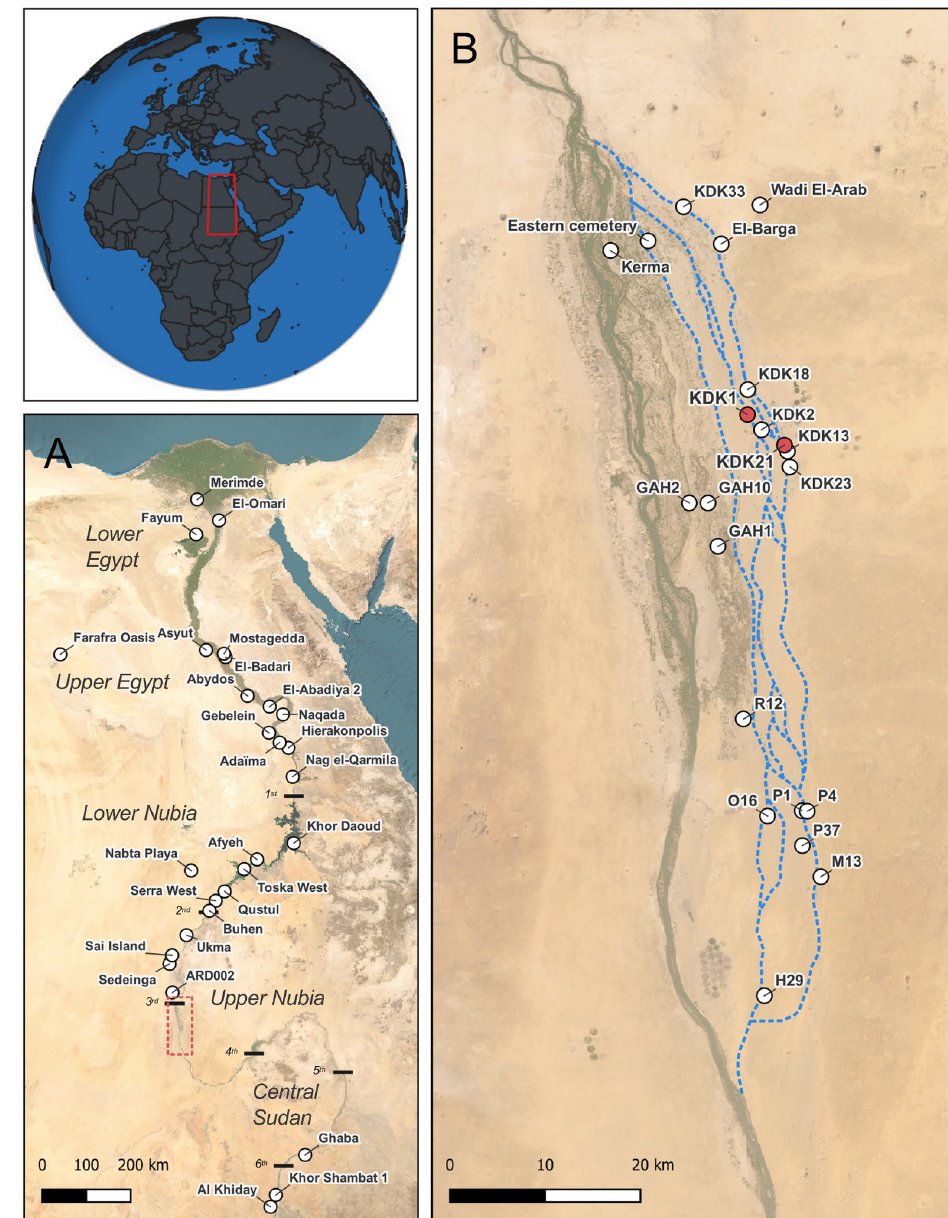
Fig 1. Locations of sites and regions discussed in the text. (A) Map of Nile Valley, red inset indicates location of panel B; (B) Map of alluvial plain and palaeochannel systems in the Northern Dongola Reach of Upper Nubia, study sites KDK21 and KDK1 indicated in red, palaeochannels indicated in blue. World Imagery base map sourced from: Esri, Maxar, Earthstar Geophysics, and the GIS User Community (ArcGIS Pro Licence